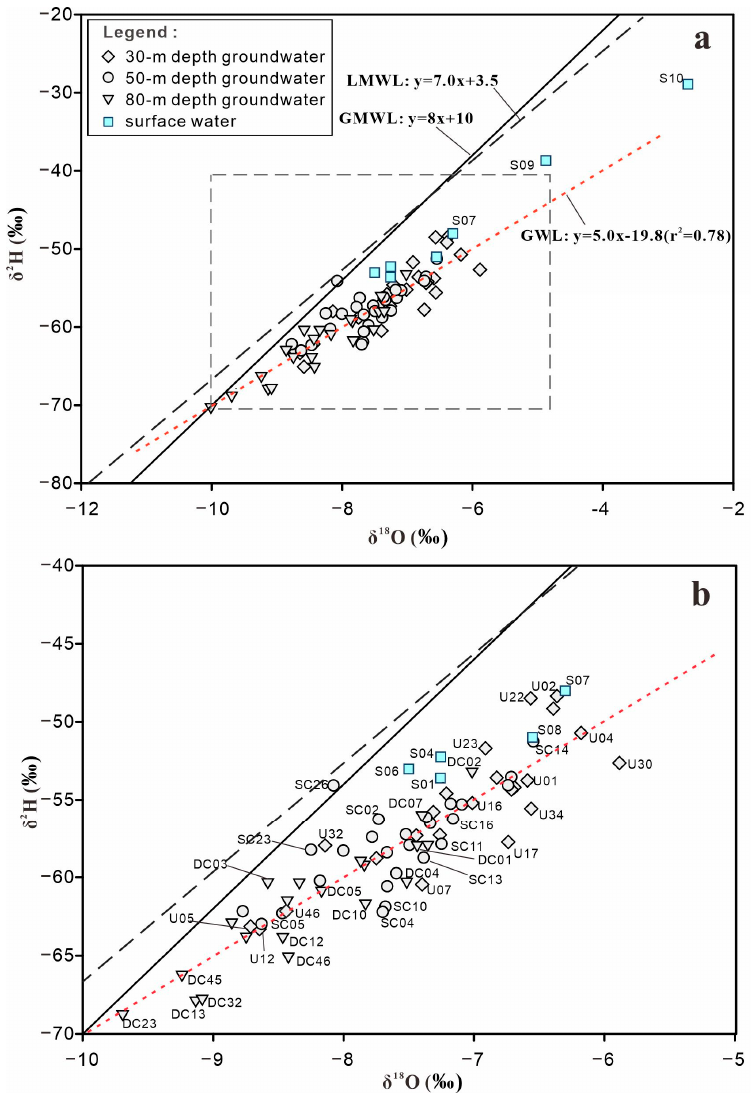
Figure 7. ( a ) δ 18 O and δ 2 H isotope compositions of groundwater in the 30-m, 50-m, and 80-m depth aquifers, as well as surface water in May 2018. ( b ) Can be zoomed from Figure 7a. GW: groundwater; GMWL: global meteoric water line [55]; LMWL: local meteoric water line [56]; and, GWL: groundwater